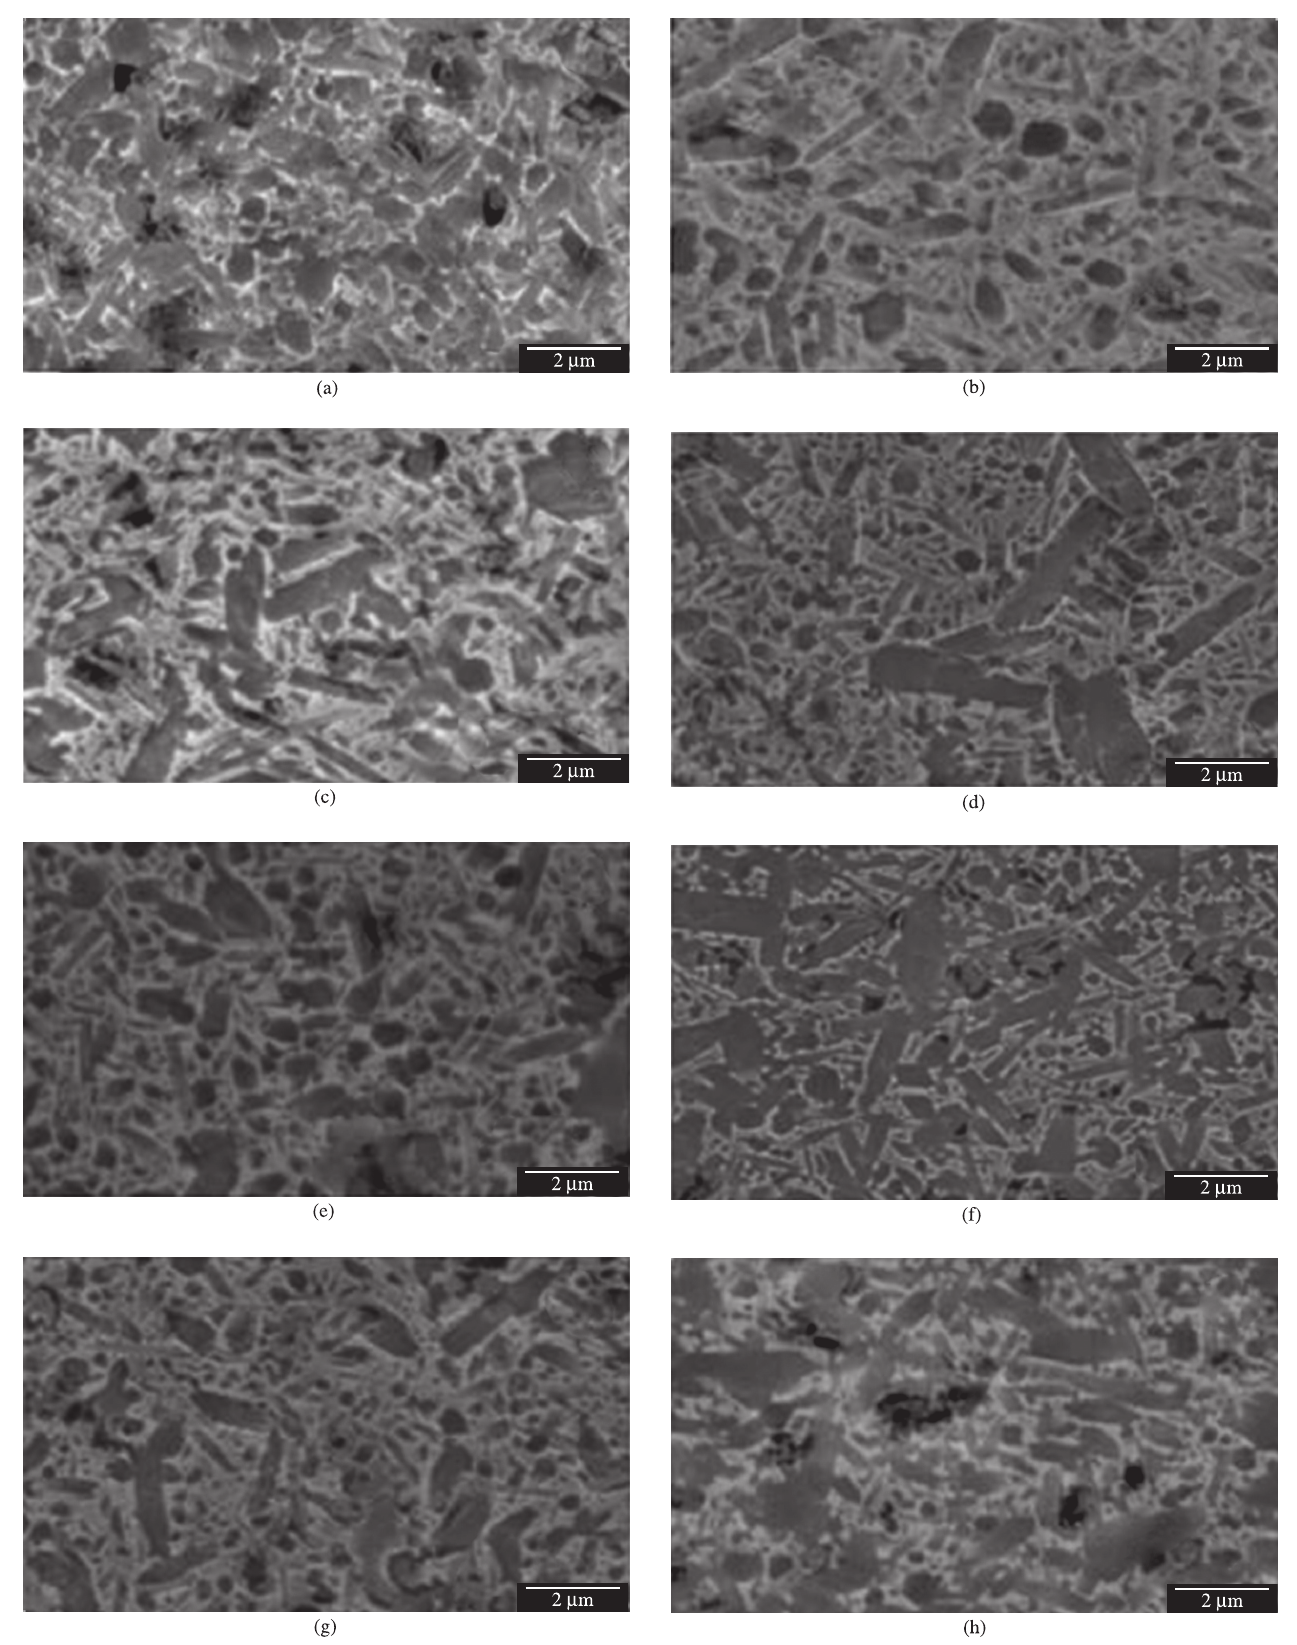
Figure 2. Scanning electron micrographs of plasma-etched silicon nitride-based ceramics with different additives (9 wt. (%)): a) SN-Y; b) SN-La; c) SN-Nd; d) SN-Dy; e) SN-Yb; f) SN-Y/La; g) SN-Y/Yb; and h)